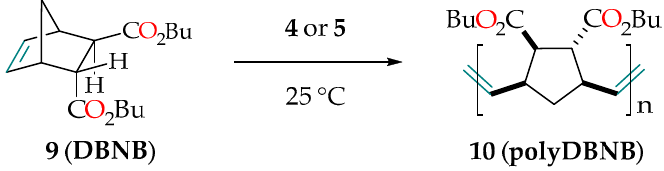
Figure 5. Time/conversion curves for RCM transformations of 7 (0.8 mmol, 200 mg) to 8 under the action of catalysts 4a – d and 5a – d . Conditions: catalyst loading is 0.01 mol% (0.00008 mmol), 25 °C, Ar, dry CH 2 Cl 2 (20